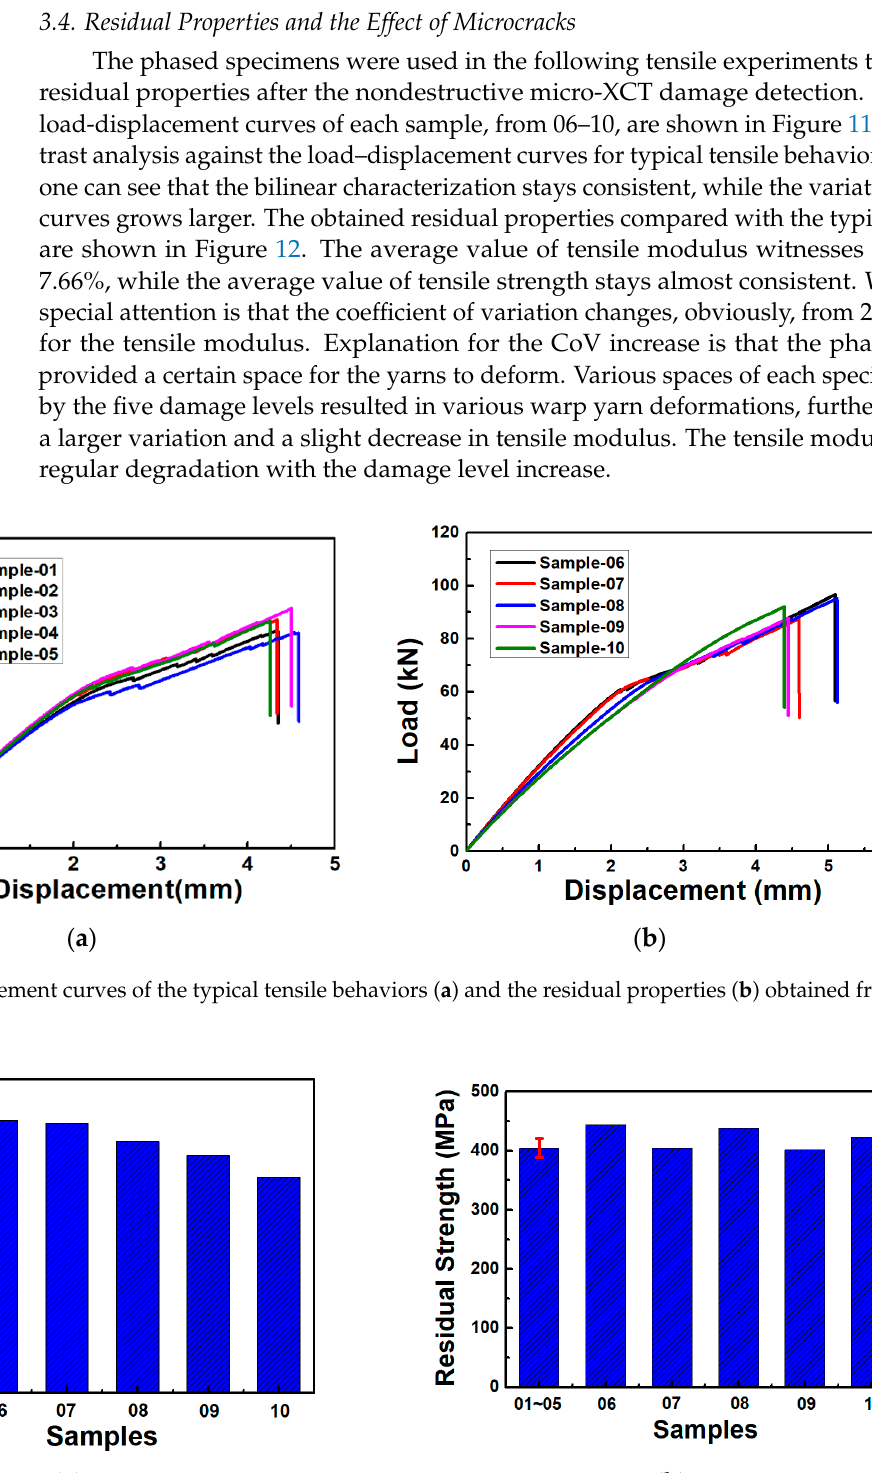
Figure 13. Normalized tensile properties changes vs. the CVF, showing the effect of microcracks.